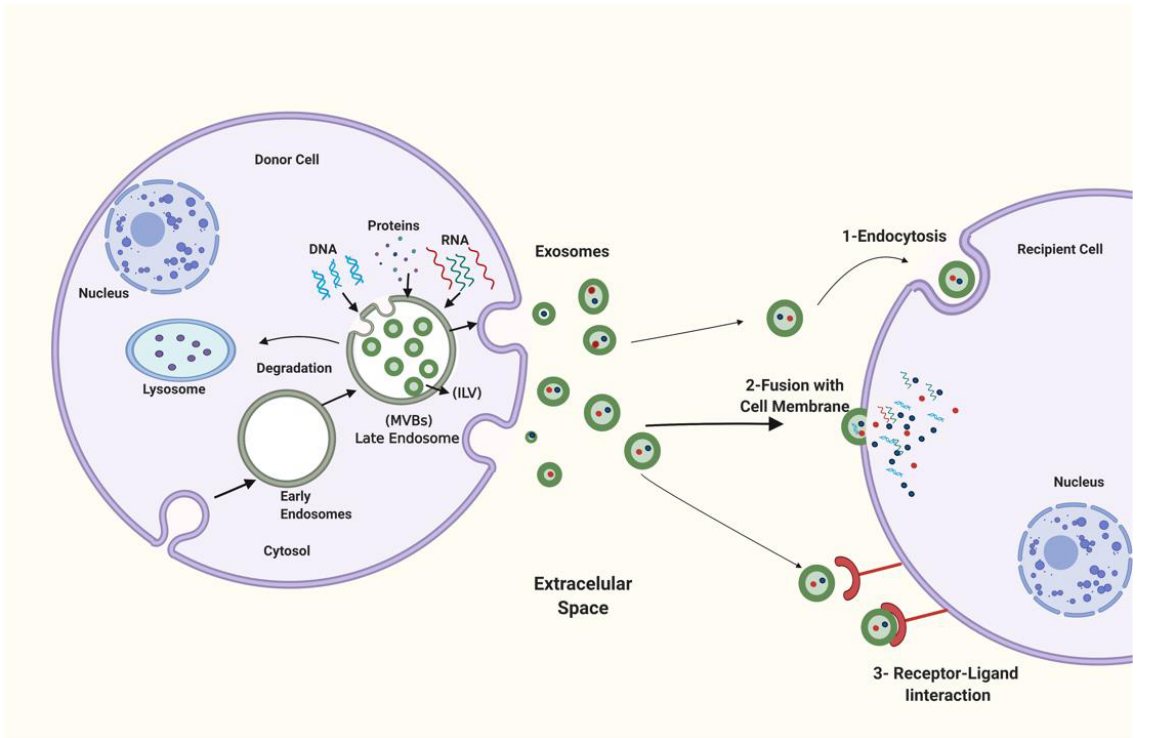
Figure 2. Exosome formation, discharge, and uptake. Late endosomes, often known as Multivesic- ula r bodies (MVBs), form exosomes. Multivesicular bodies’ membranes bud inward and generate various sizes of exosomes known as intraluminal vesicles (ILVs). In this step, RNAs, proteins, and DNA are loaded onto exosomes. Multivesicular bodies’ may be degraded in the lysosome or re- leased through the extracellular fluid by merging into the cell membrane. After that, the three ways that exosomes engage with the receptor cell are ( 1 ) endocytosis, ( 2 ) a direct fuse between the exo- some membrane and the cell membrane, and ( 3 ) an interaction between the ligand and